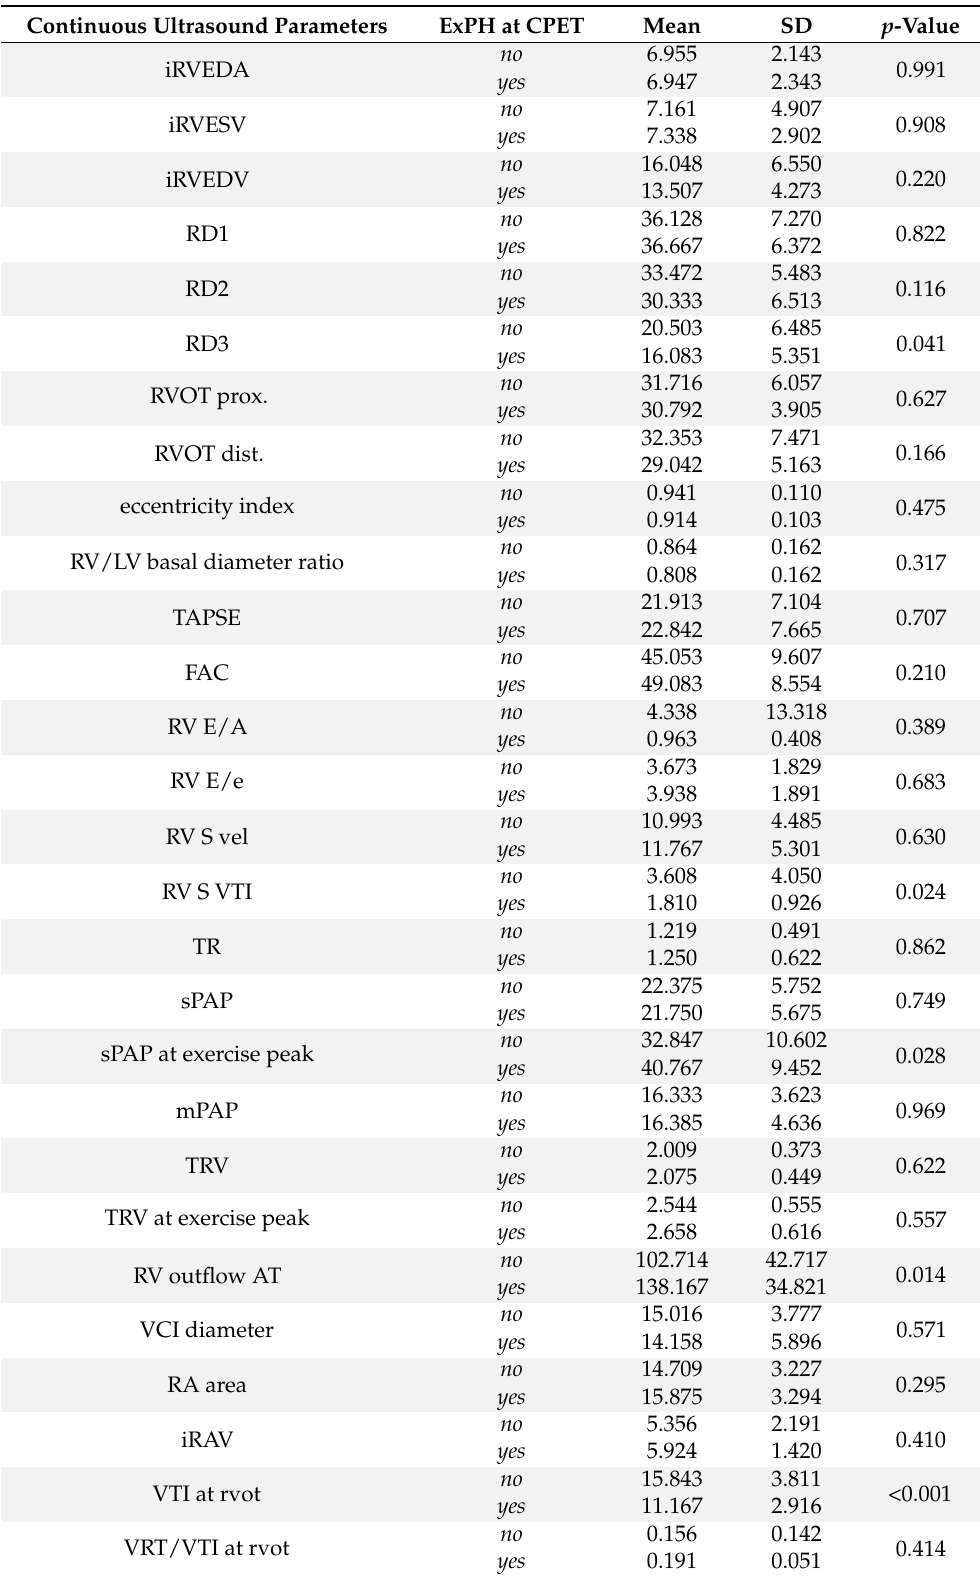
Table A3. Cont . Continuous Ultrasound